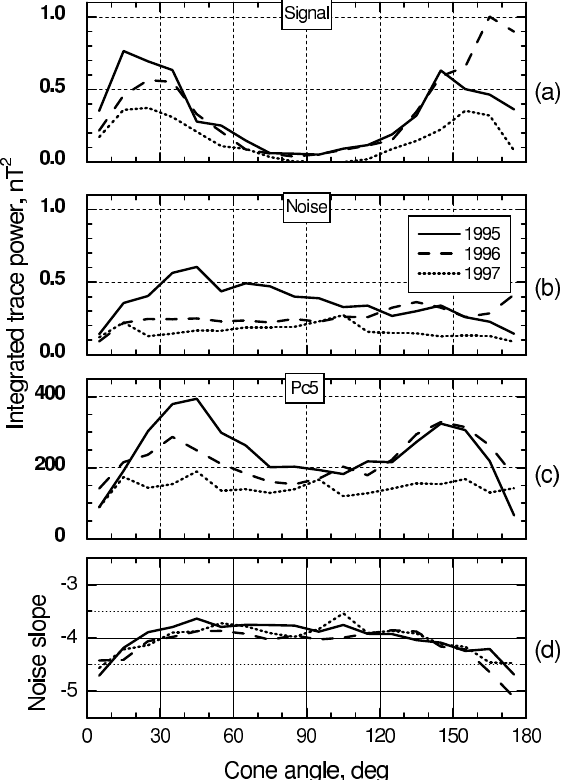
Fig. 9. Cone angle dependence at Davis over 1995–1997 for (a) Pc3 signal , (b) noise , (c) Pc5 trace power, and (d) noise